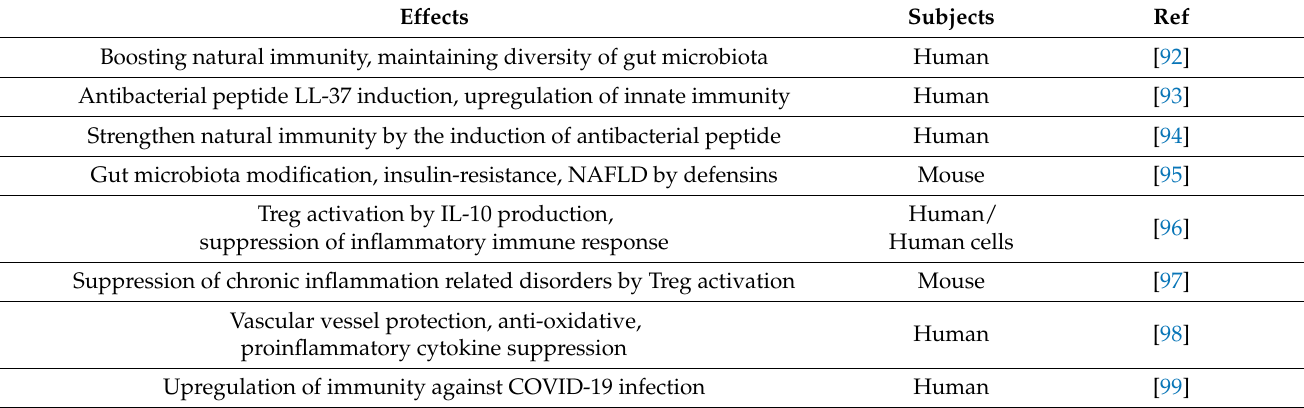
Table 3. Anti-metabolic syndrome and anti-inflammatory effects of vitamin